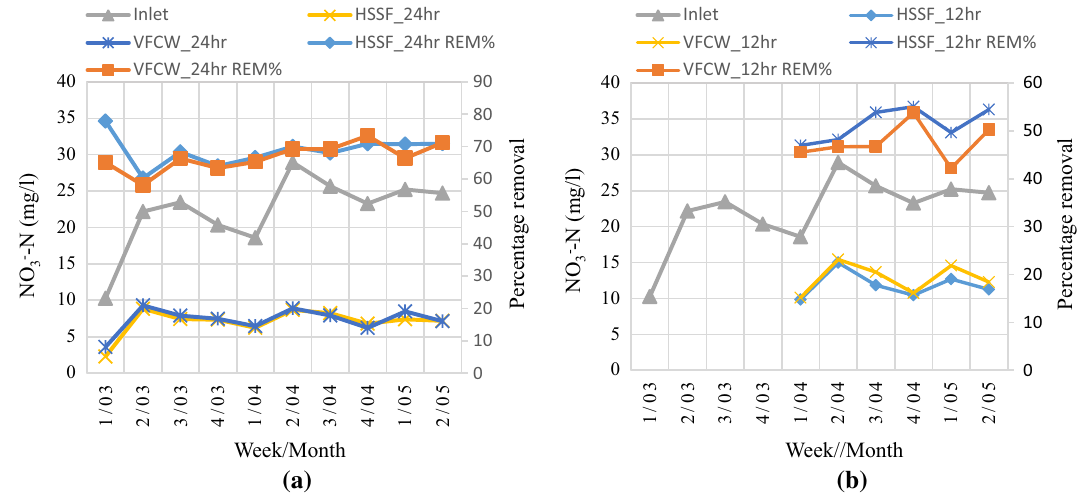
Fig. 7 a Nitrate nitrogen (NO 3 –N influent, effluent concentration and percentage removal of HSSF-CW and VFCW for 24-h HRT, b nitrate nitrogen (NO 3 –N influent, effluent concentration and percentage removal of HSSF-CW and VFCW for 12-h